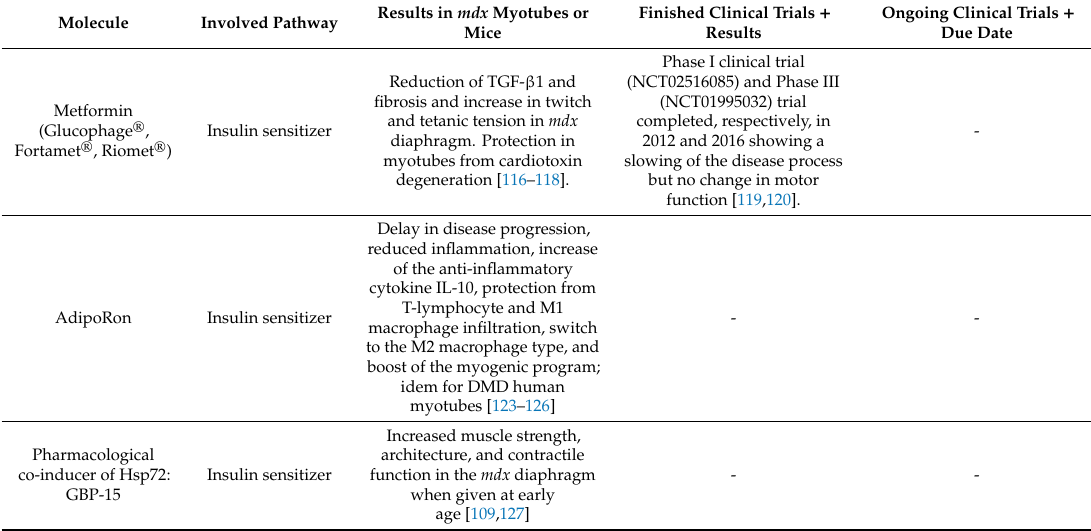
Table 6. Overview of glucose metabolism stabilizing molecules: results in mdx myotubes (in vitro) or mice (in vivo), finished clinical trials and results, ongoing clinical trials and due dates, and putative